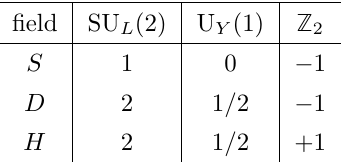
Table 1 . Particle content and charge